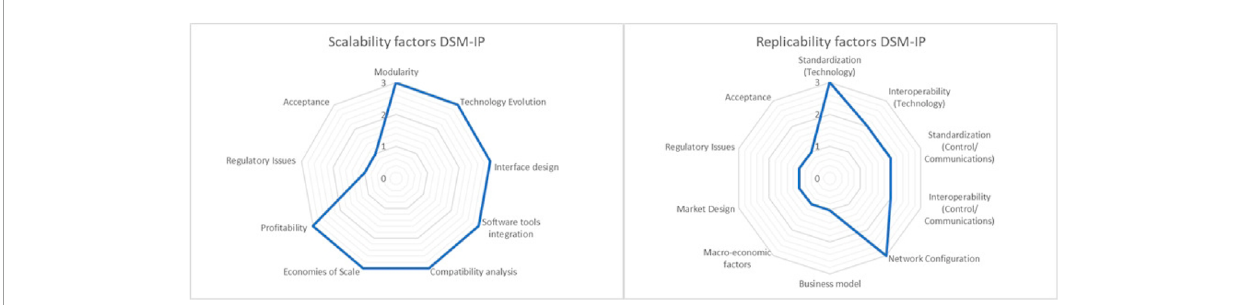
FIGURE 7 Spider graph on DSP-IP scalability and replicability assessments.